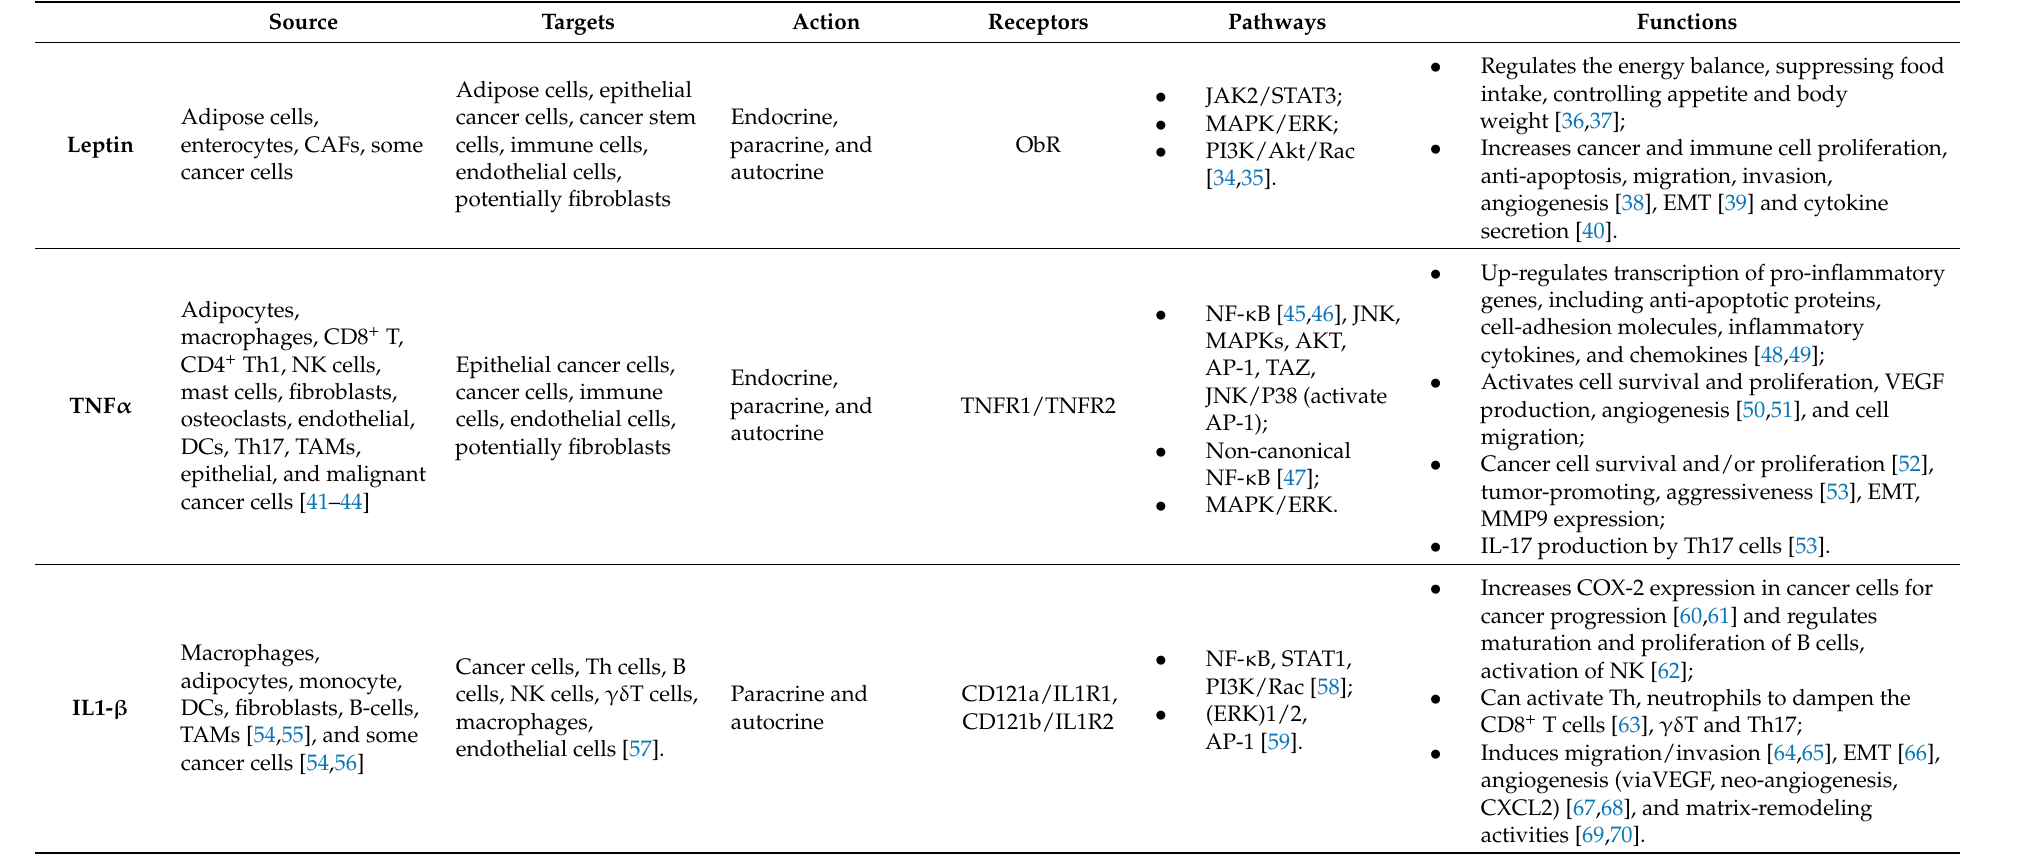
Table 1. Main sources, target cells, receptor types, activated pathways, and functions of each